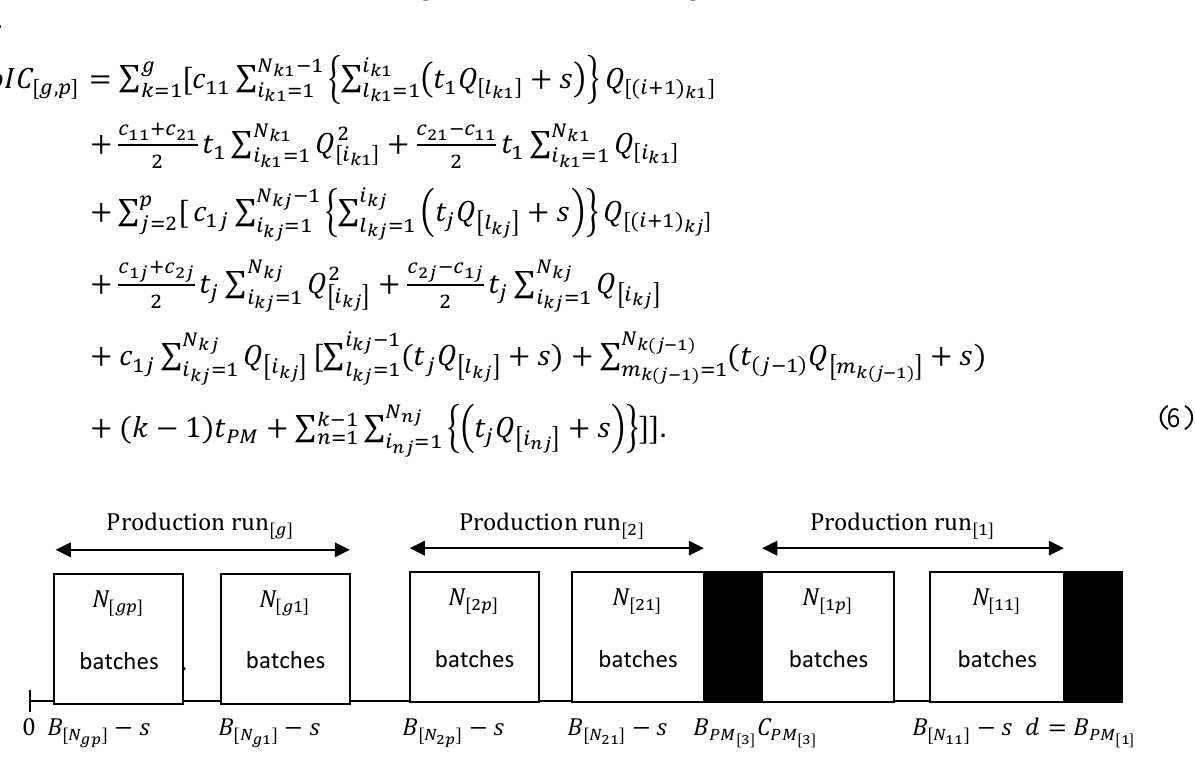
Fig. 4. Batches position in multiple items single machine with g production